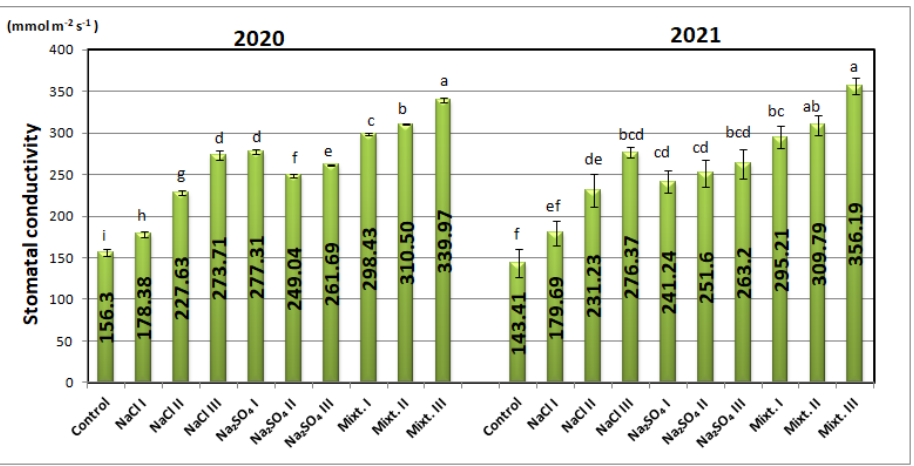
Figure 5. Stomatal conductivity for N. cataria L. variants with significant differences at 0.001 level indicated with letters.